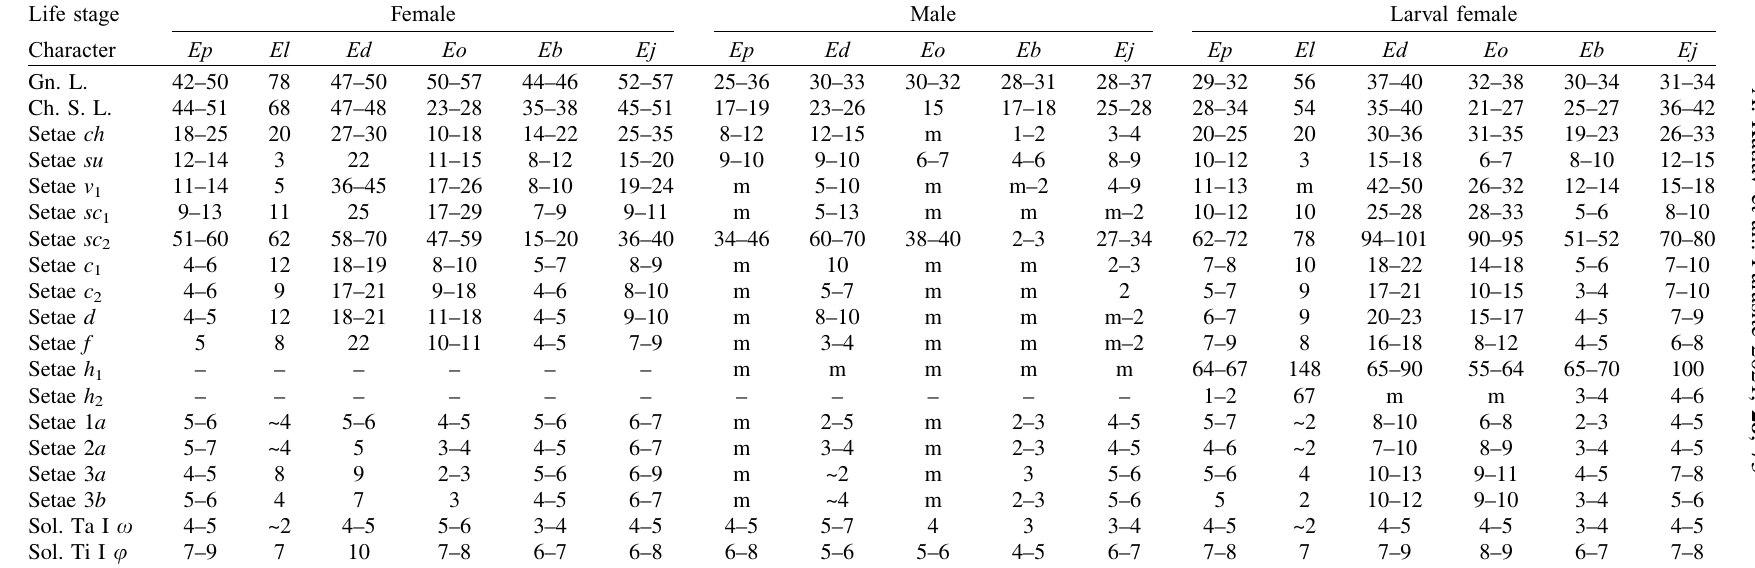
Table 2. Comparison of selected characters (range of measurements if available) of all the described species of the leytei species group in the genus Eutarsopolipus (male is unknown for